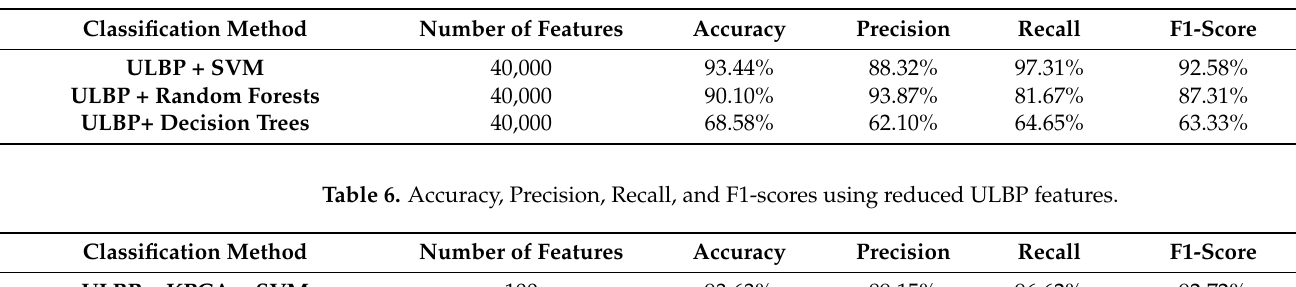
Table 4. Accuracy, Precision, Recall, and F1-scores using reduced HOG features.